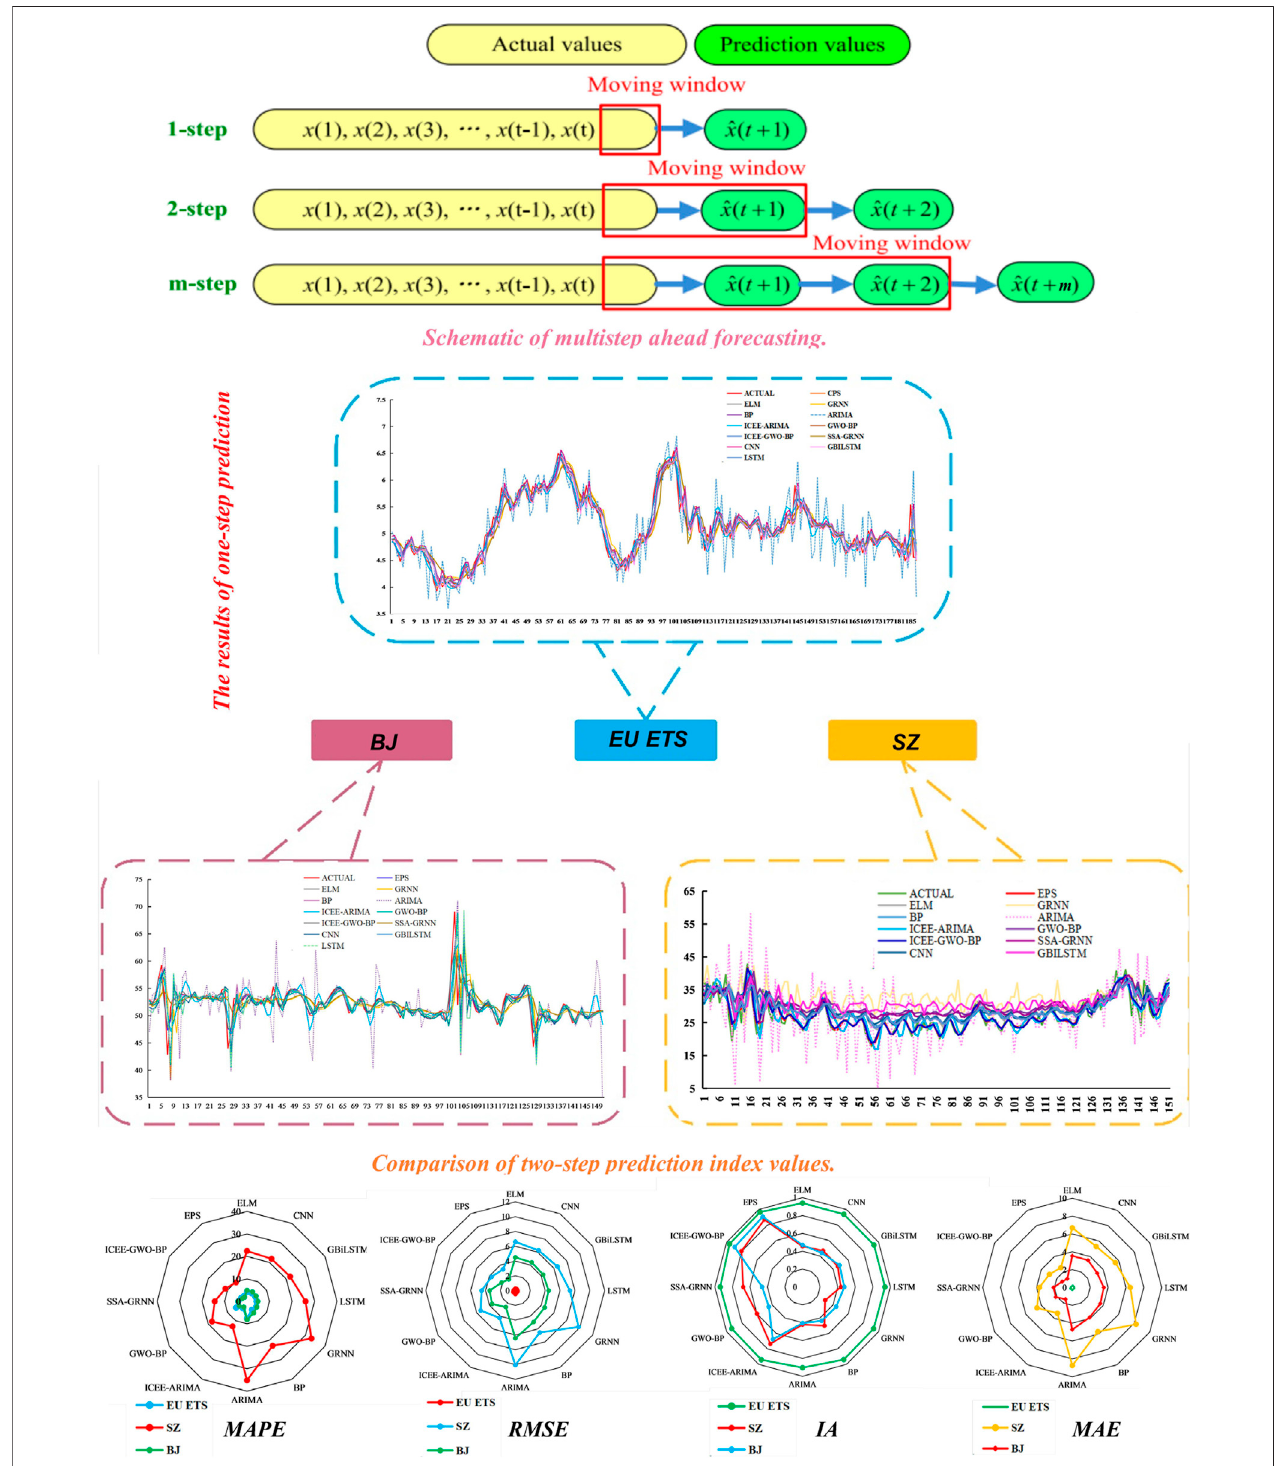
FIGURE 3 | Prediction results obtained using EPS and comparison models under different prediction steps.